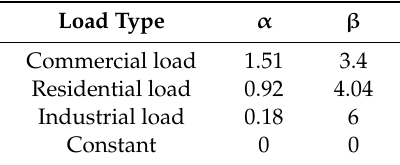
Table 1. Load types and exponent